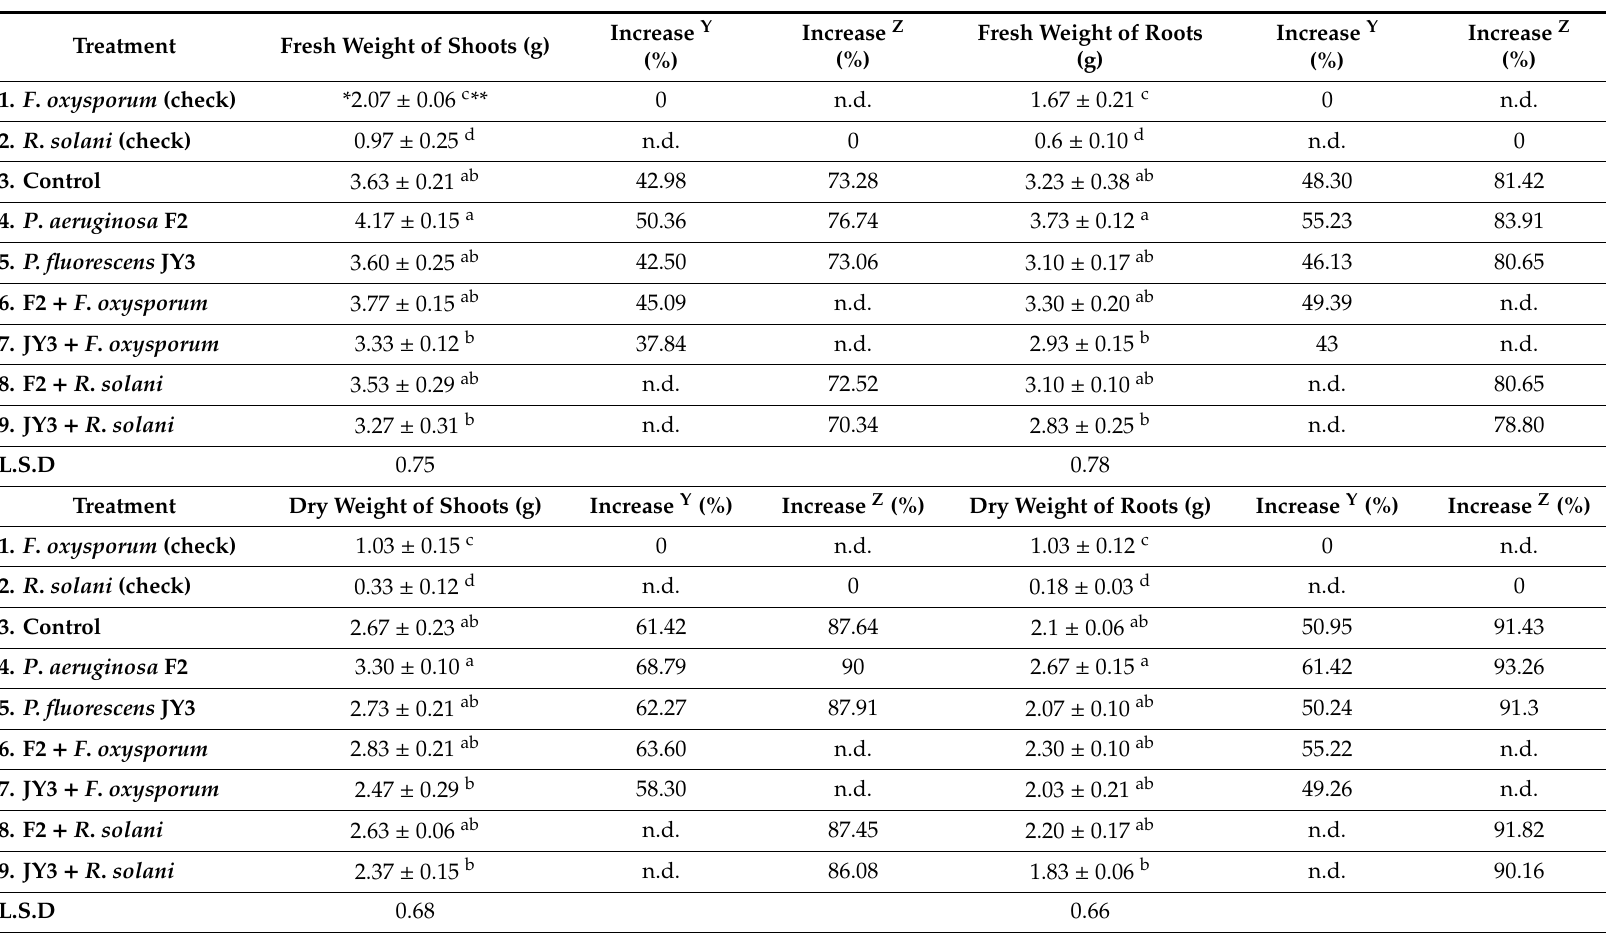
Table 4. E ff ect of culture formulations of Pseudomonas aeruginosa F2 and Pseudomonas fluorescens JY3 on fresh and dry weight of shoots and roots of wheat plants.